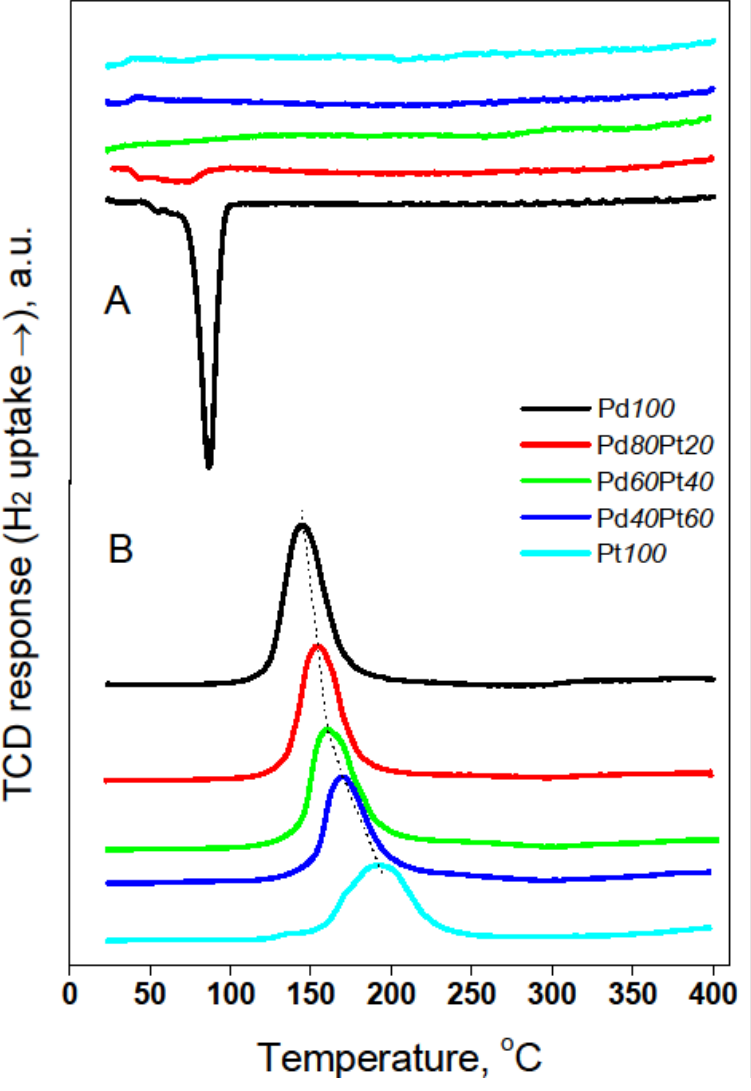
Figure 1. Temperature-programmed reduction (TPR) profiles of Pd–Pt/C, ( A ) ex-acac series, ( B ) ex-chloride series.